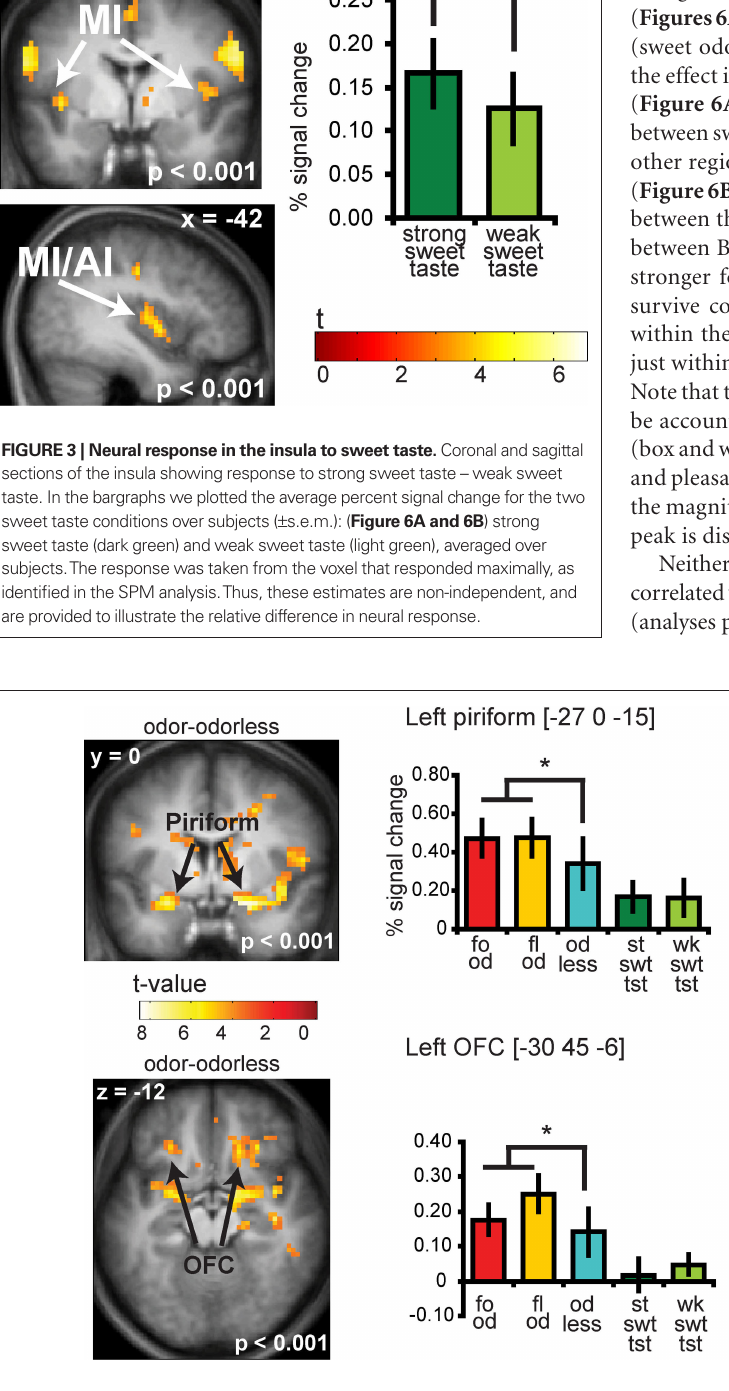
FIguRe 4 | Coronal and axial sections showing neural response to food and floral odors vs. odorless air in bilateral piriform and OFC. The bar graphs show the percent signal change for the three odor conditions: food odors (fo od, red), floral (fl od, yellow), and odorless air (od less, blue) ( ± s.e.m.), averaged over subjects). The response was taken from the voxel that responded maximally, as